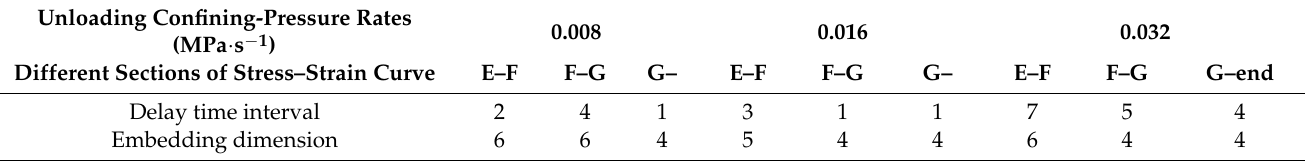
Table 1. Delay time interval and embedding dimension of the strain-energy sequence.